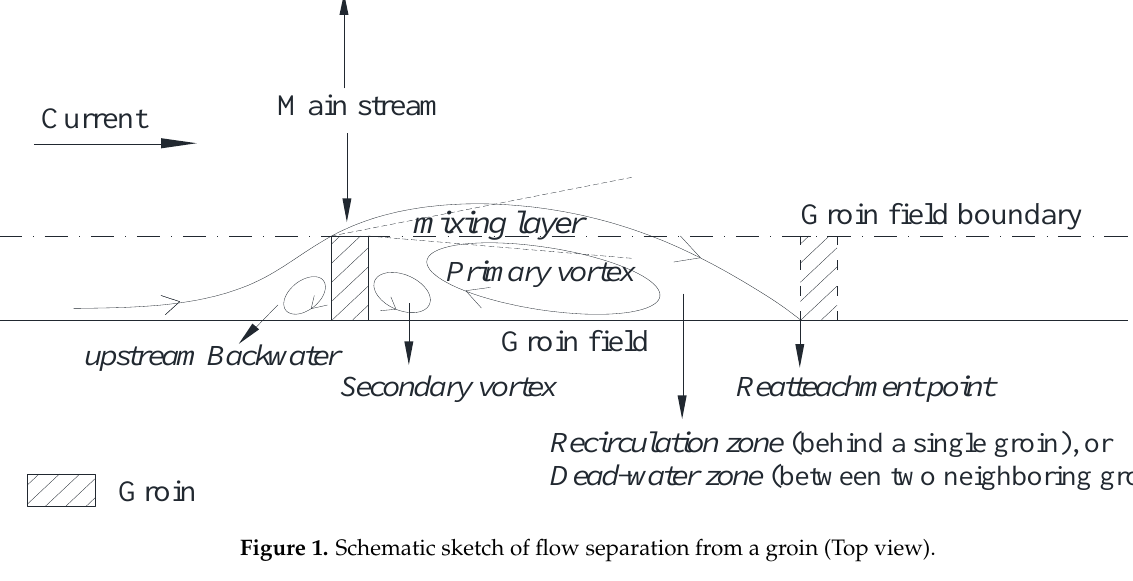
Figure 1. Schematic sketch of flow separation from a groin (Top view). The flow within the groin field is virtually stagnant and has a permanent open con- nection with the main stream, resulting in a continuous exchange of mass and momentum between the groin field and main stream [23]. Using the planar velocity measurement with Particle Image Velocimetry (PIV), Weitbrecht and Jirka [24] conducted an experimental work of the flow patterns around two groins and the mass exchange processes between the recirculation zone and the main stream. The exchange process was found to be governed by the 2D flow structure generated at the groin tip, which grows in the horizontal direction mainly between two groins because the flow is very shallow. Based on flume experiments and field measurements, Sukhodolov et al. [25] found that the recirculating flow patterns in the groin fields depend mainly on the ratio between groin length and groin field length. The aspect ratio of 0.5 is the critical value at which the flow pattern changes from one-vortex to two-vortex in the groin fields. Subsequently, more details regarding vortex flow in groin fields were experimentally investigated by Uijttewaal [26]. By increasing the distance between groins further, the flow pattern on the downstream side of the groin field changes while, on the upstream side, the primary and secondary vortices remain qualitatively the same [26]. More flow details near river groins were further experimentally investigated